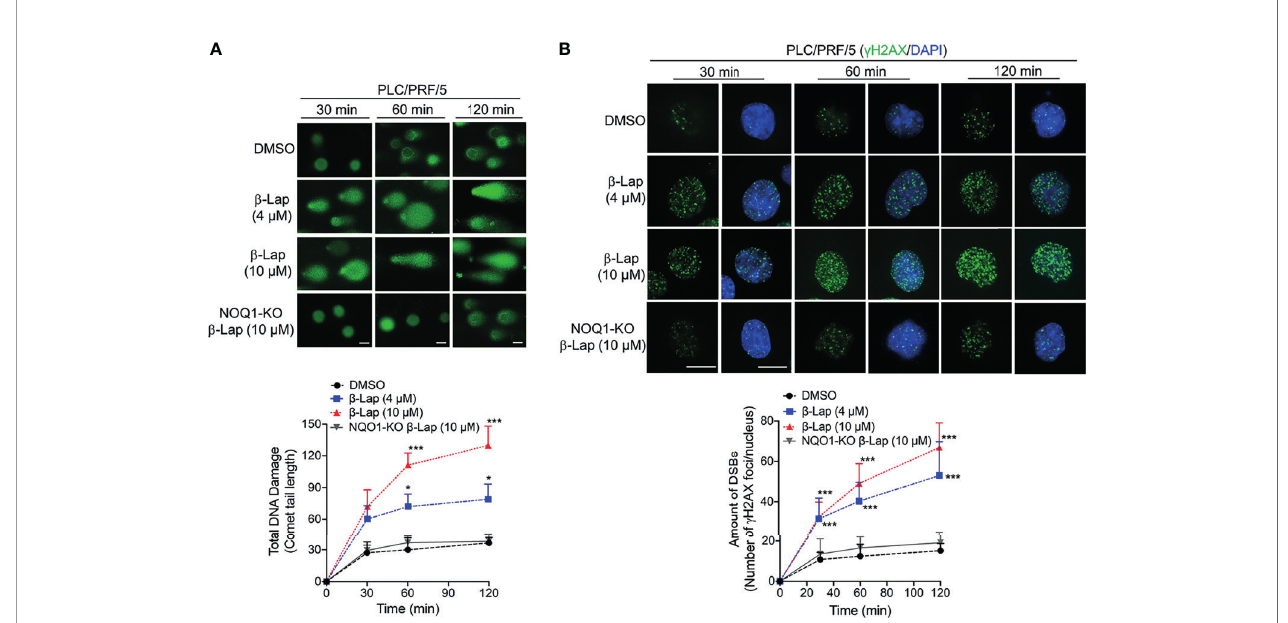
FIGURE 5 | b -Lapachone induces NQO1-dependent DSB formation in hepatocellular carcinoma cells. Wild-type or NQO1 knockout PLC/PRF/5 cells were treated with a sublethal (4 µM) or lethal (10 µM) dose of b -lap for the indicated time (min), and then total DNA lesions were assessed using the alkaline comet assay. (A) Comet tail lengths were imaged under an immuno fl uorescence microscope. (B) DSBs were quanti fi ed by g H2AX foci/nuclei. Data represent the means ± SDs. Student ’ s t tests were performed. Scale bar = 10 µm, *** p < 0.001, * p <